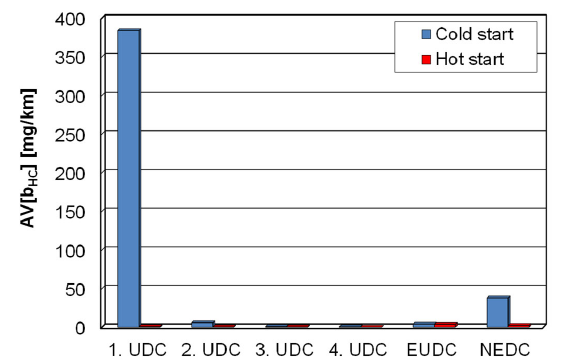
Figure 11. Average hydrocarbons emissions (AV[b HC ]) in four parts as well as in the NEDC test for cold and hot starts.